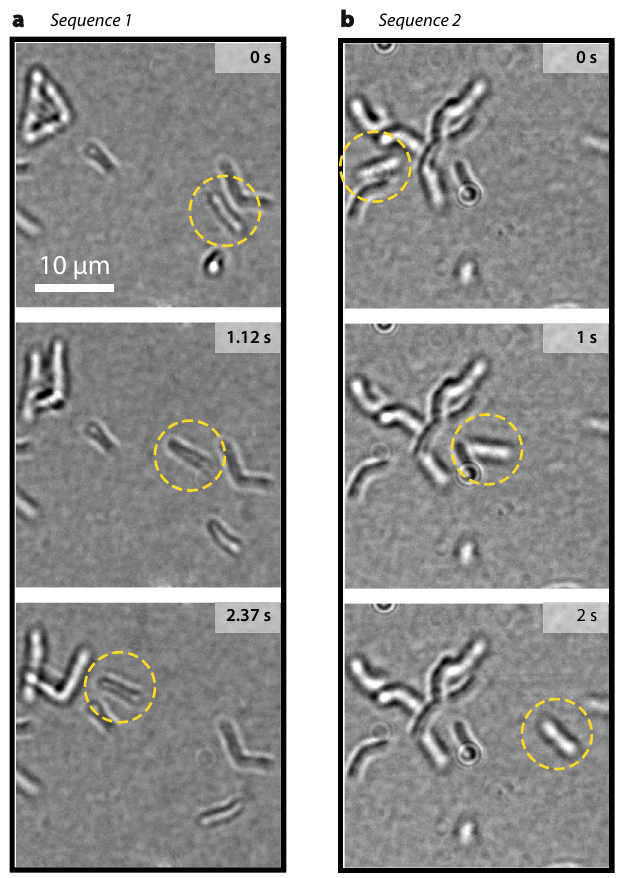
Fig.5|Bacterialswim. Twotimelapses,( a )and( b ),showingtheswimmingoftwo different bacteria, spotted using dashed circles. Images were extracted from Movie M5 (available as Supplementary